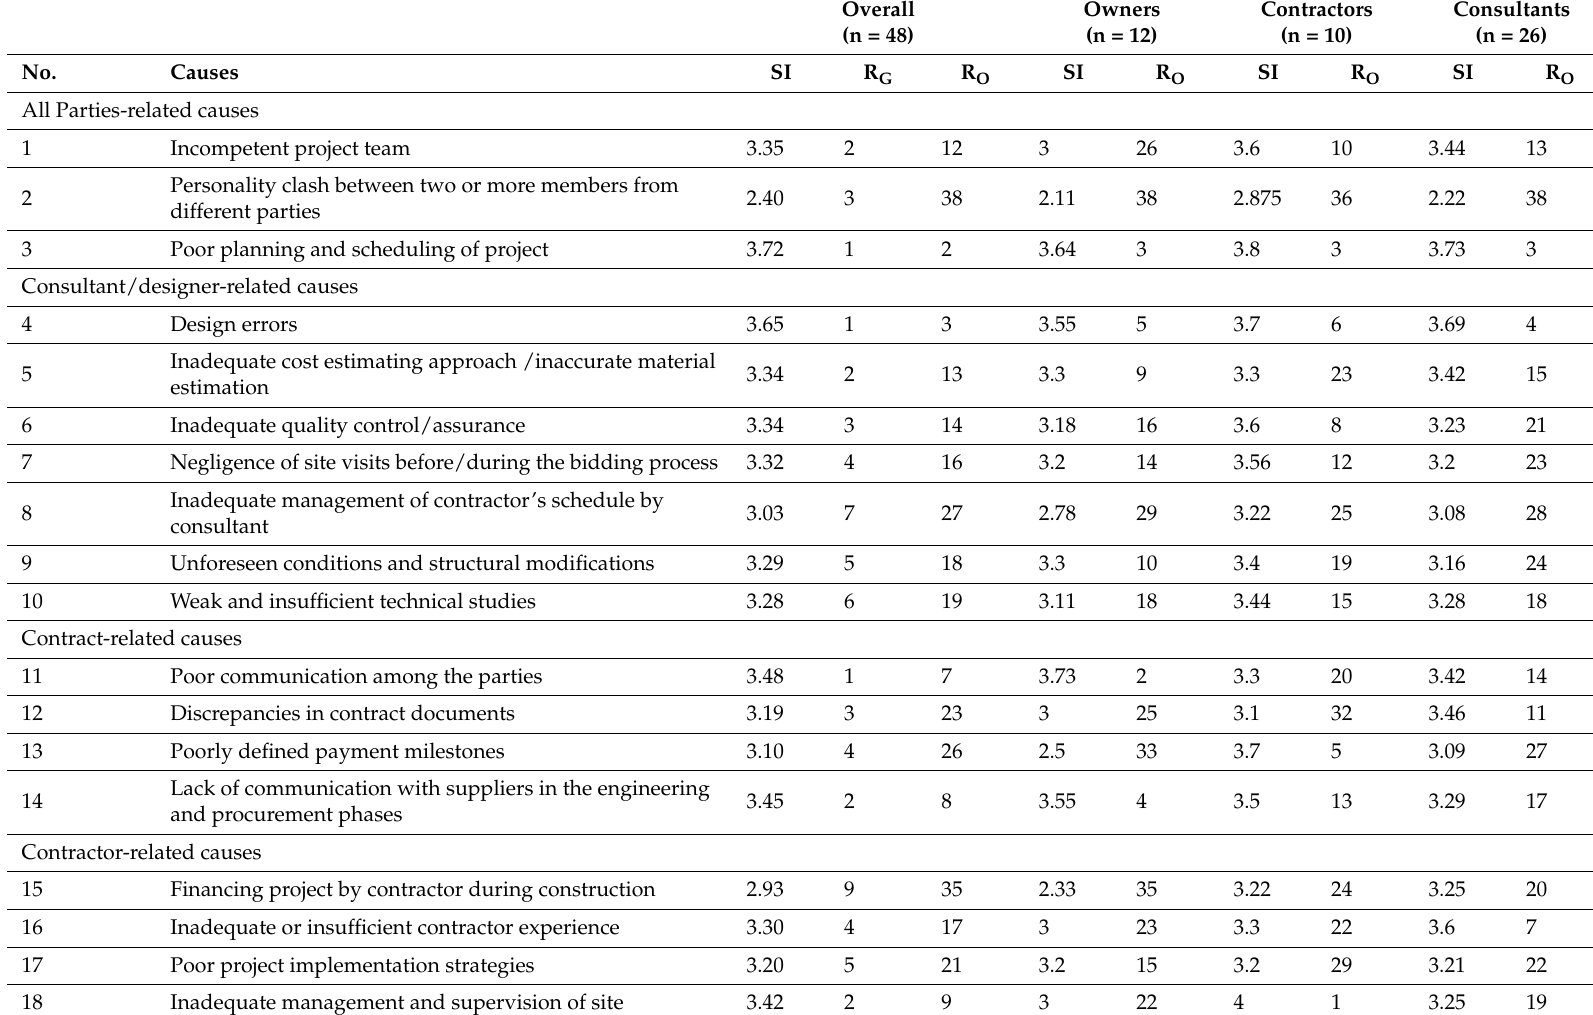
Table 2. Overall, owners, contractors and consultant significant index of causes of time and cost